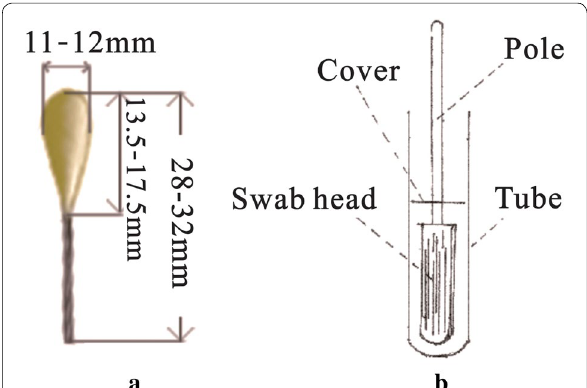
Fig. 1 A schematic diagram of the swab: a the size of the swab, and All local strains were from the b the swab immersed in the sample tube, which is covered with a Wuhan Centers for Disease silicone plug to prevent